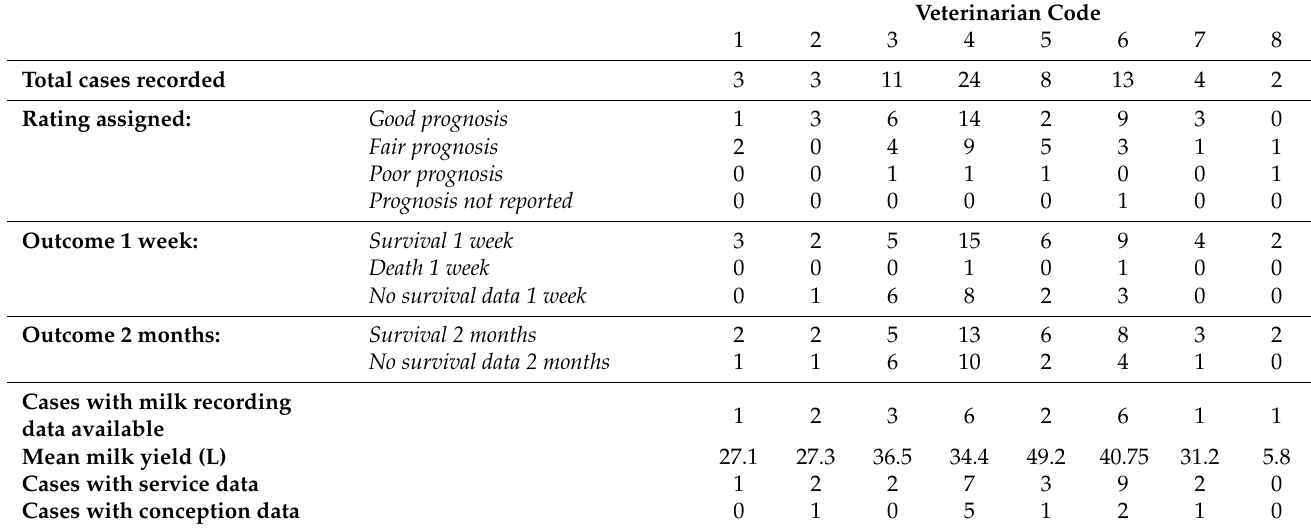
Table 6. Recorded findings from the LDA surgery clinical audit carried out by Practice 3 veterinarians over an 8-month